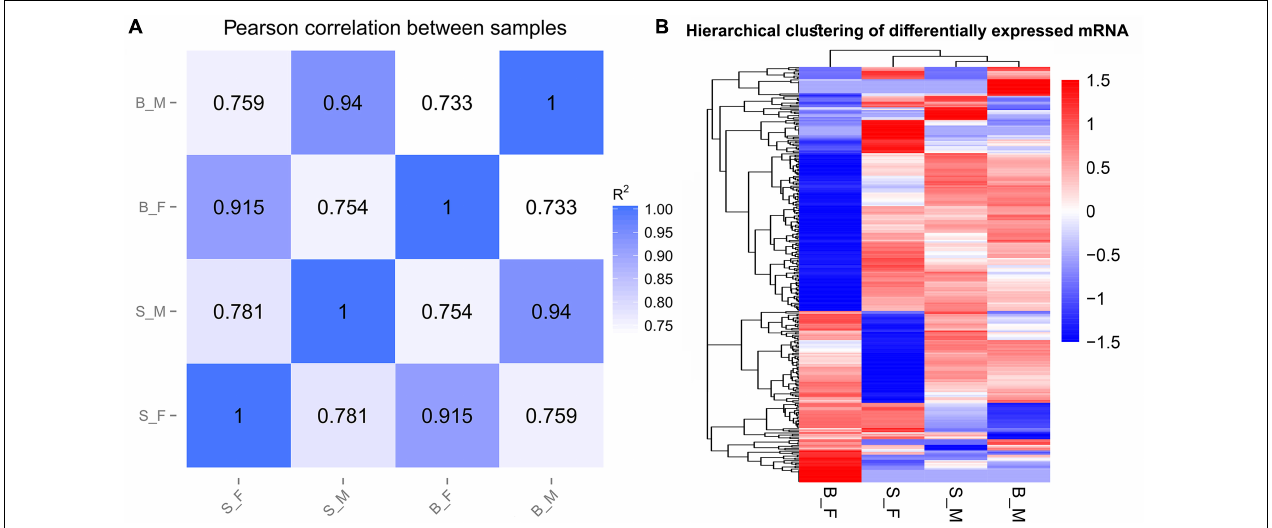
FIGURE 2 | Sample relationships revealed by two different approaches. (A) Pearson’s correlation analysis between samples. The figures in the matrix R 2 are the squares of the correlation coefficient ( r ) between two samples. (B) Hierarchical clustering based on the relative FPKM values [log10(FPKM + 1)] of all genes; scaling was done across all samples for each gene.